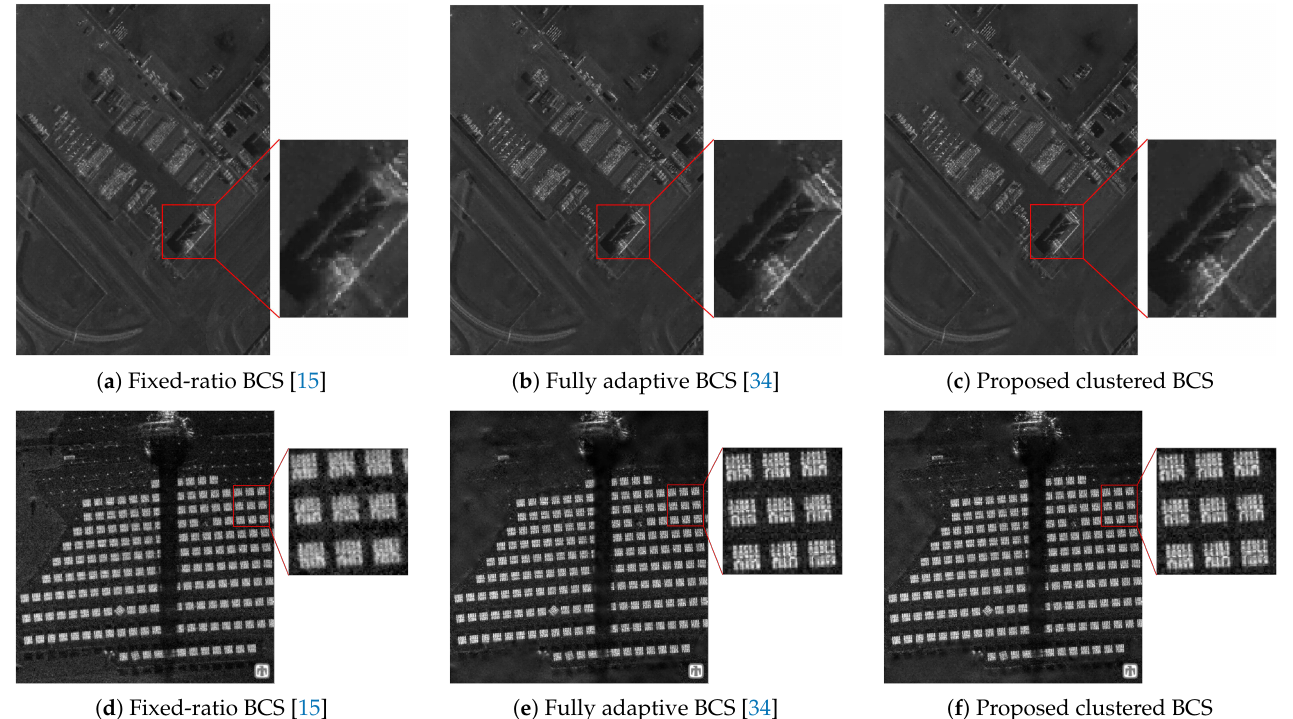
Figure 9. Reconstructed SAR images using various BCS methods when r = 0.5. The original images are Kirtland AFB2 for